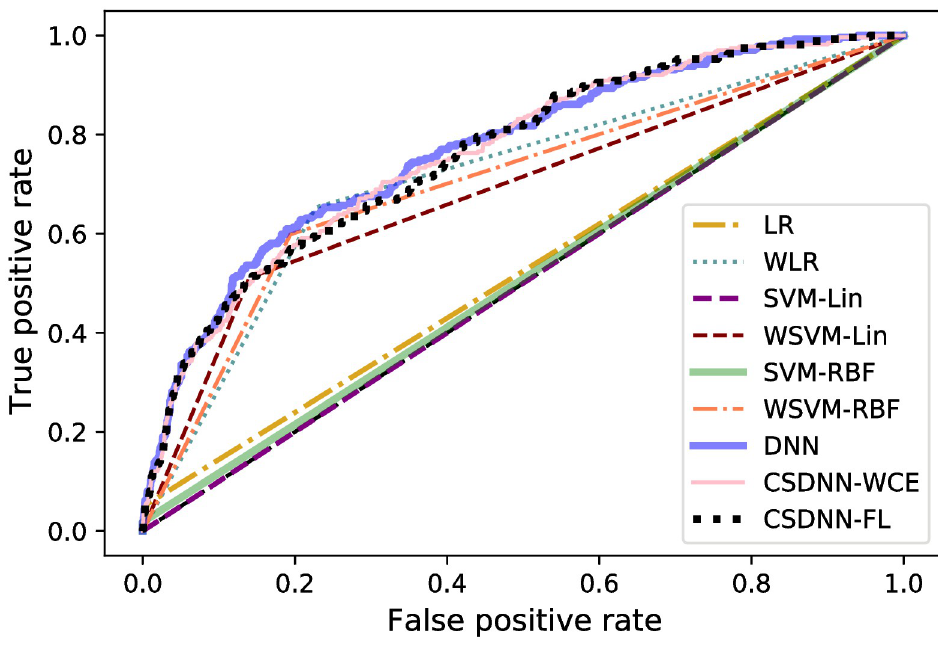
Fig 26. ROC curve for the MOMI